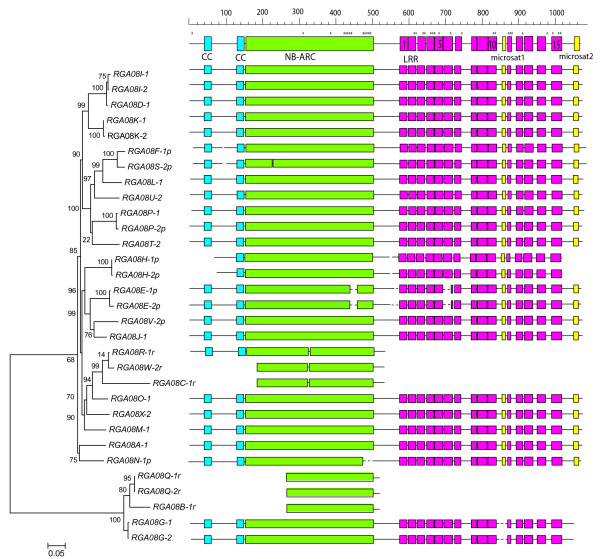
Phylogenetic relationships of RGA08 predicted CDS and schematic representation of the corresponding CC-NB-LRR domains. Different colored boxes indicate the RGA protein domains identified manually after a multiple RGA08 CDS alignment. Blue boxes represent the N-terminal coiled-coil region (CC). Green boxes represent the nucleotide-binding region and the ARC domain shared by APAF-1, R and CED-4 proteins (NB-ARC domain). Pink boxes represent the 15 leucine-rich repeats (LRR). Yellow boxes represent simple sequence repeats. Sites predicted to be under positive selection according to PAML analysis are indicated by stars. The sizes of boxes and gaps between domains are drawn according to scale.